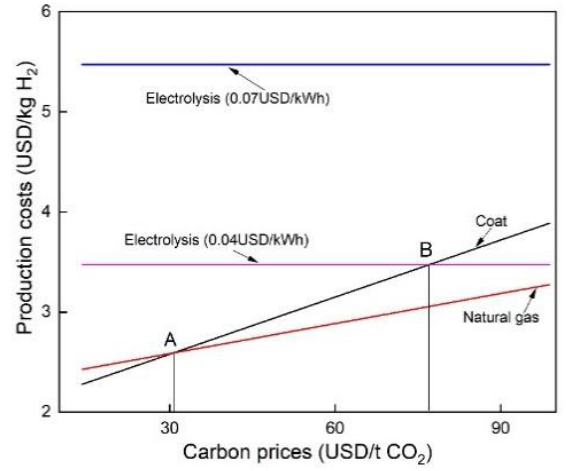
Figure 6. Hydrogen production cost (including carbon trading).